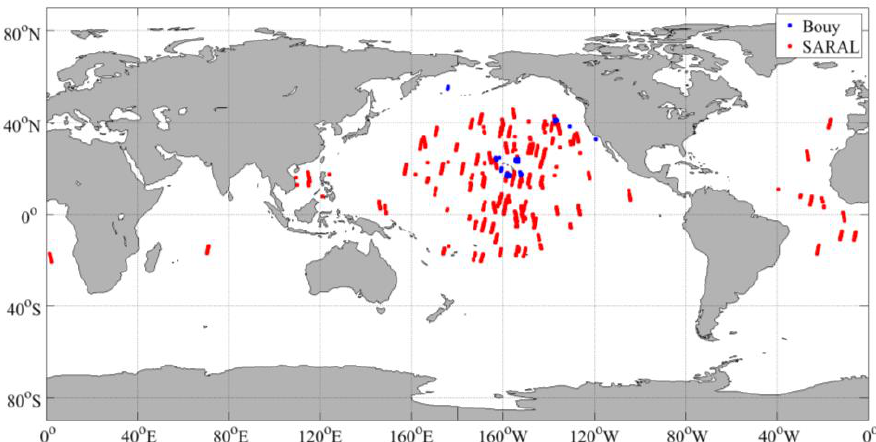
Figure 4. Map of collocations between Gaofen-3 wave mode data and SWH observations from NDBC buoys (blue) and Saral altimeter(red).